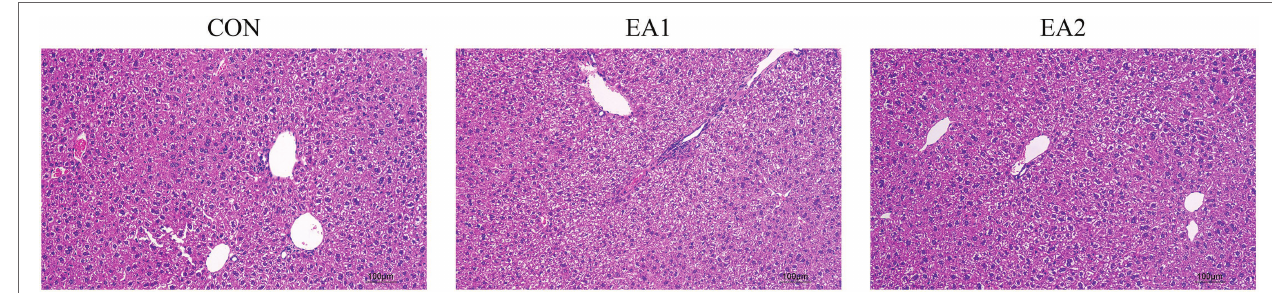
FIGURE 2 | Effects of EA supplementation on the liver as disclosed by morphological analysis (H&E staining, magnifications of 100×).